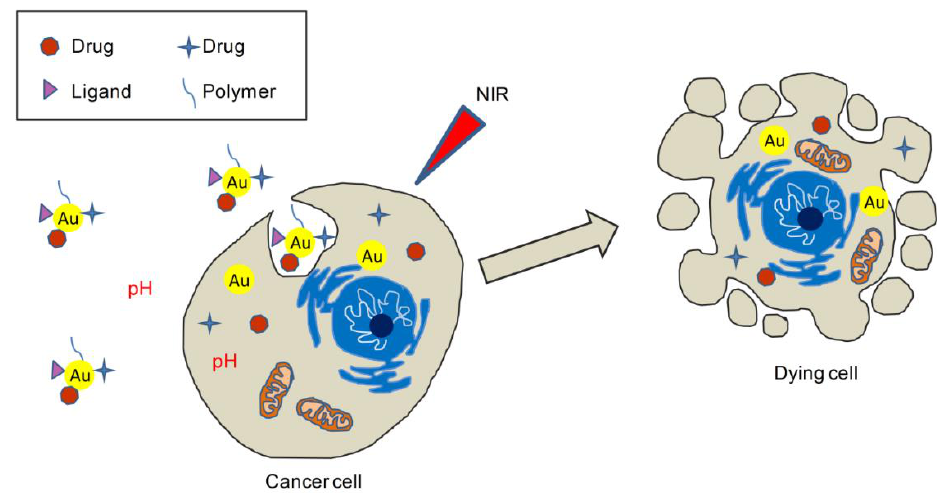
Figure 20. AuNPs may be employed as active targeted, NIR- and pH-responsive drug delivery systems, allowing a synergic effect between drug chemotherapy and PTT/PTD in cancer